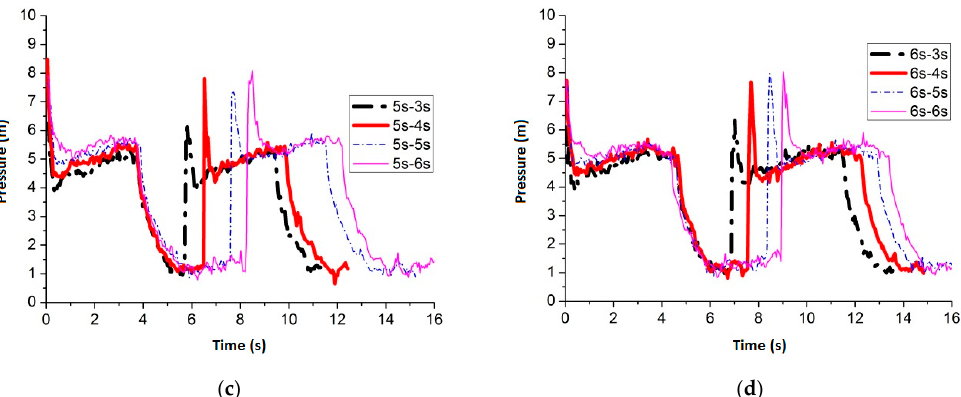
Figure 9. Pressure fluctuation of No. 1 sensing point (round nozzle at the bottom of the pipe): ( a ) air inflow time is 3 s; ( b ) air inflow time is 4 s; ( c ) air inflow time is 5 s; and ( d ) air inflow time is 6 s.